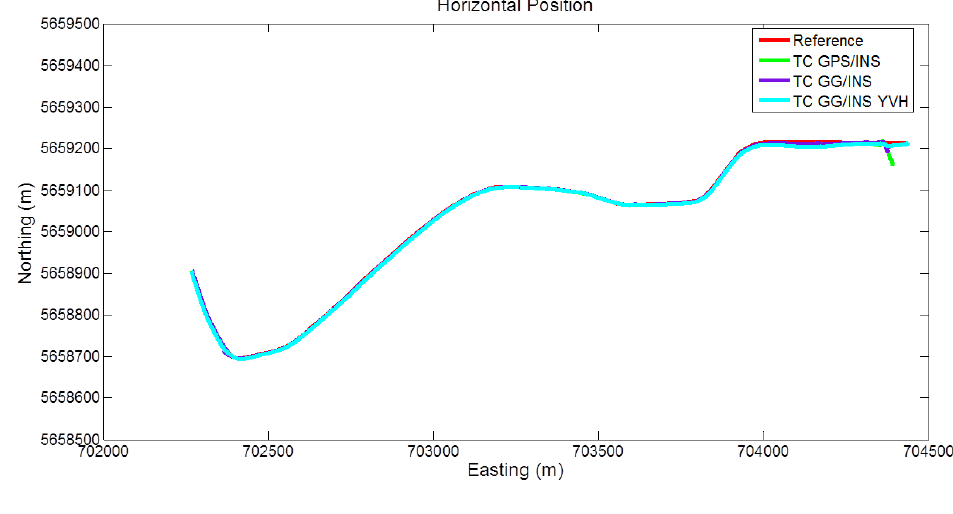
Figure 15. Trajectories obtained with the tight coupling approach (Segment